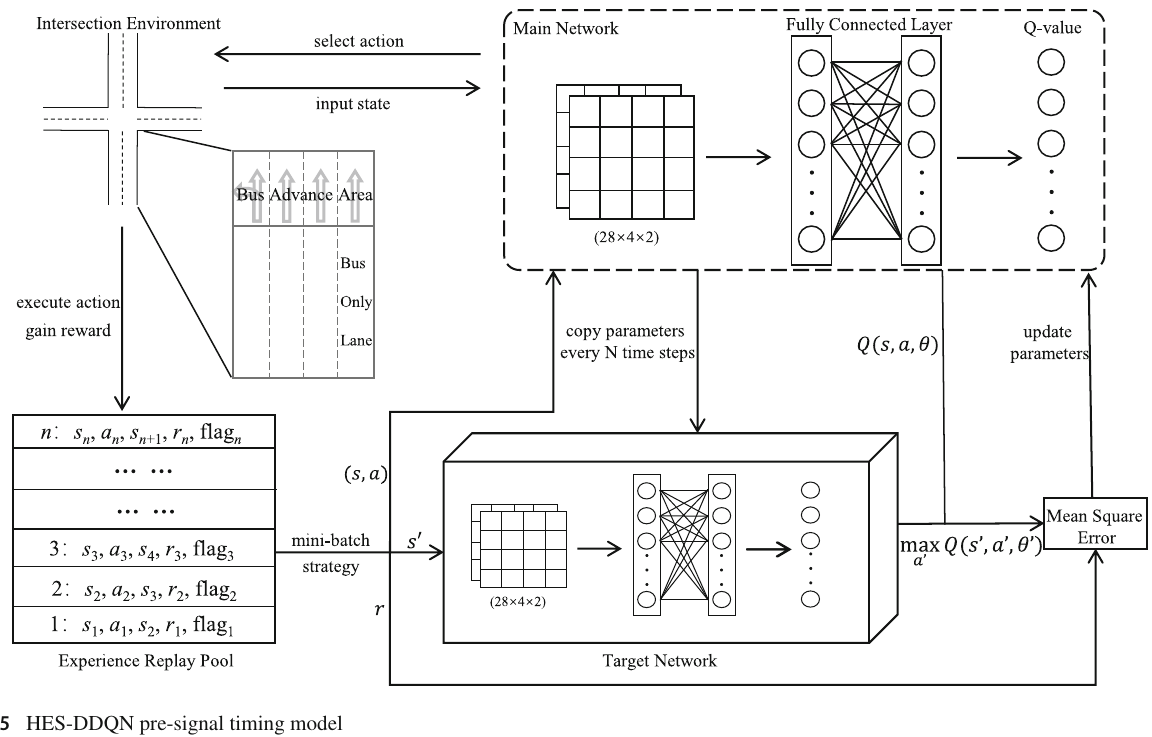
Fig. 5 HES-DDQN pre-signal timing model